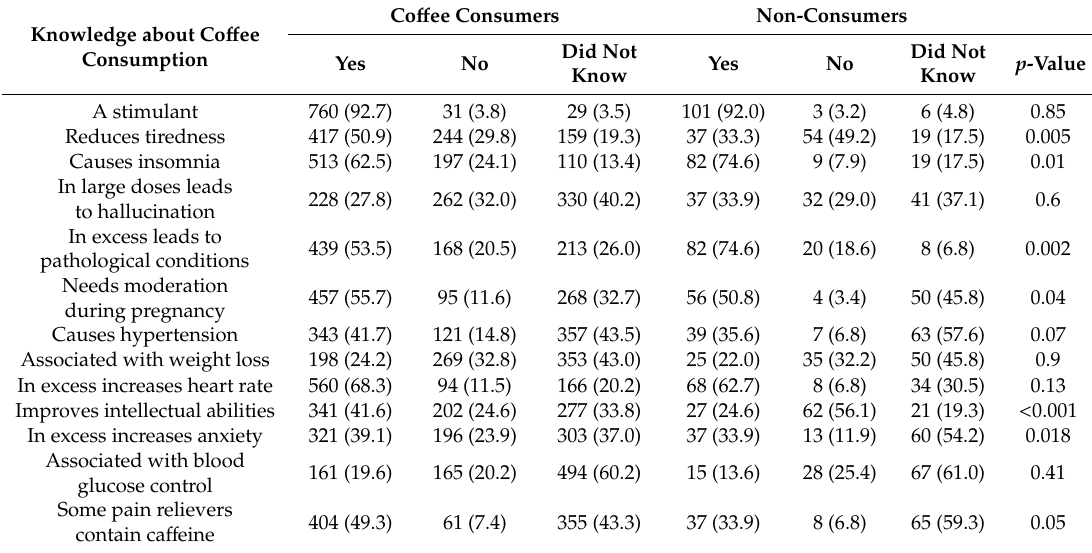
Table 4. Health awareness associated with co ff ee consumption.